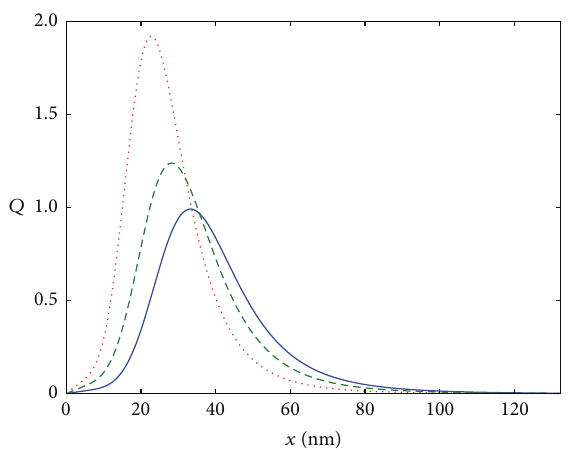
Figure 5: The badlands function 𝑄(𝑥) for an antihydrogen atom with energy 𝐸 = 10 neV; from bottom to top: perfect conductor (full line), silicon (dashed line), and silica (dotted line).